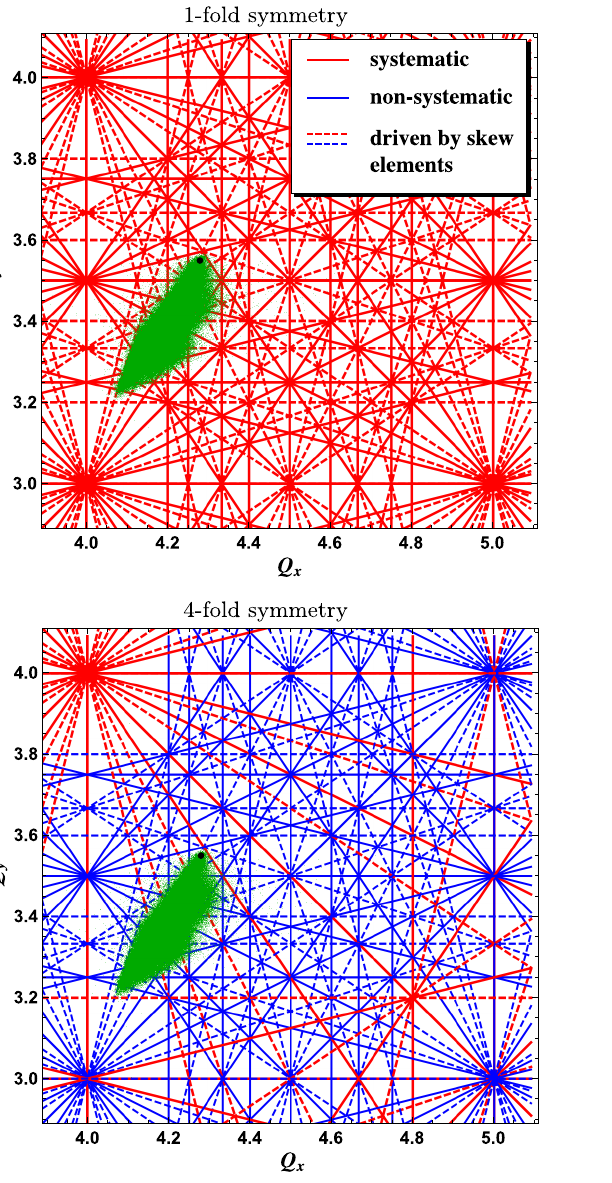
FIG. 25. Resonance diagram up to 5th order and tune footprint after 5000 turns for the 16-cell triplet lattice with onefold, twofold, fourfold and 16-fold